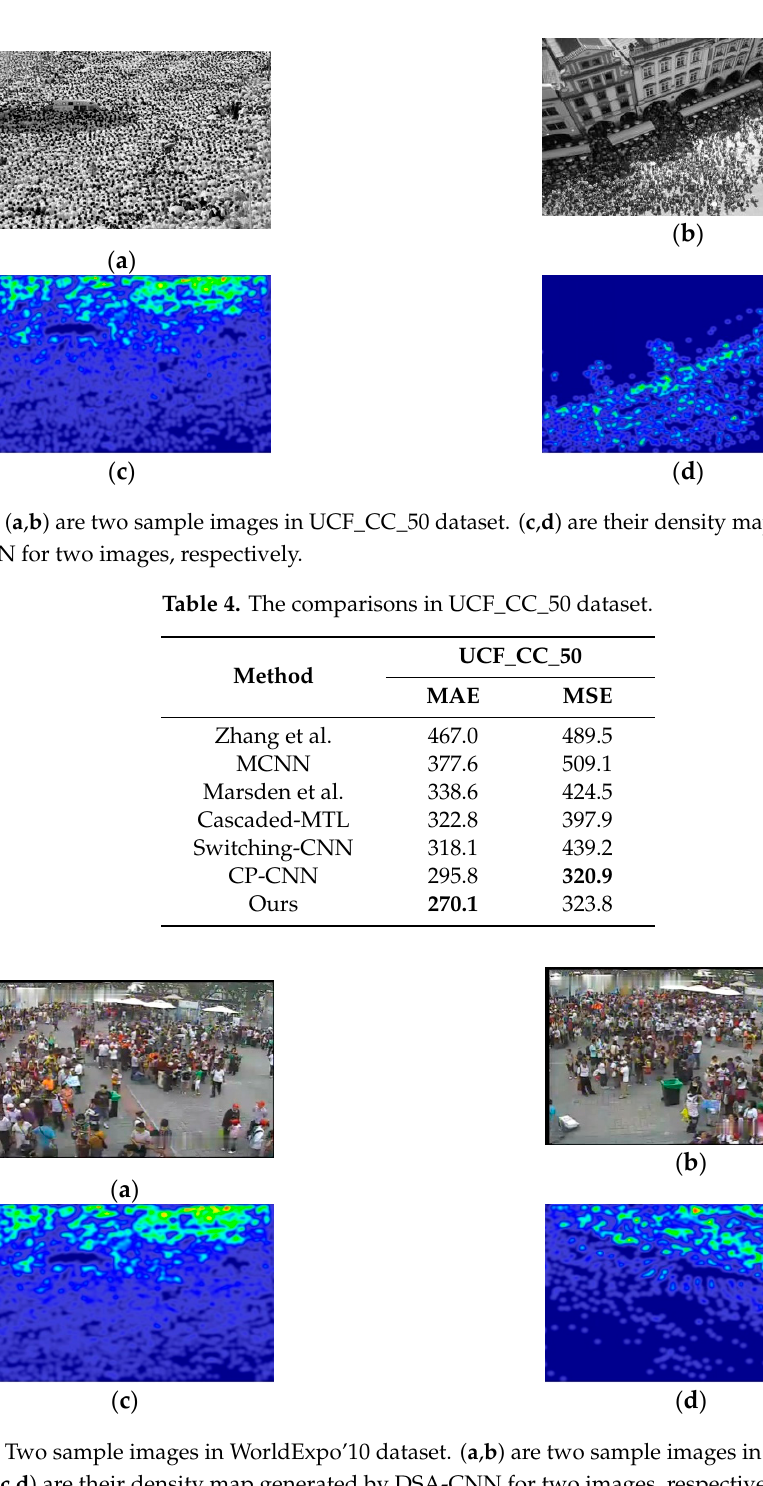
Figure 9. The comparison of MAE with seven methods in five different scenes.